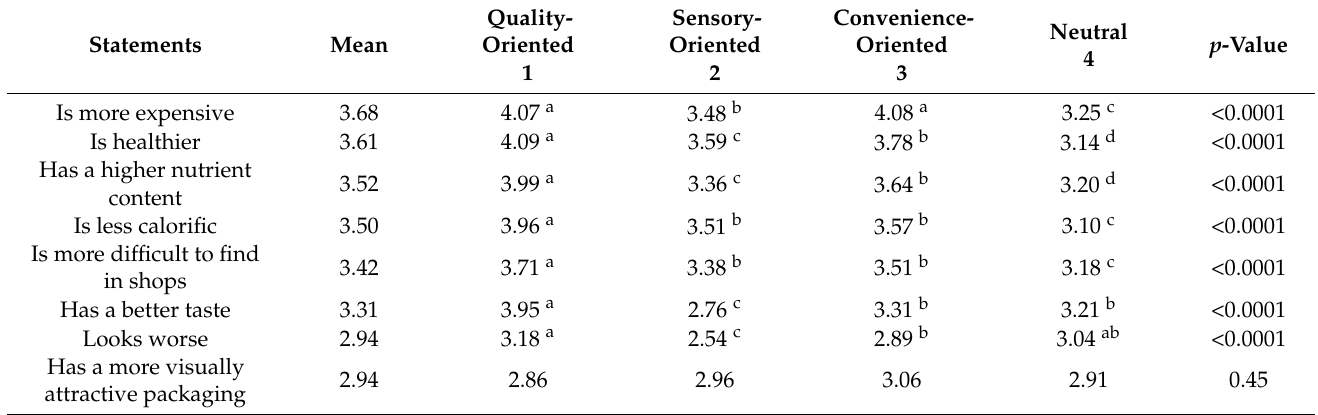
Table 8. Profile of segments in terms of statements referring to pasta with added fiber compared to the same pasta but without